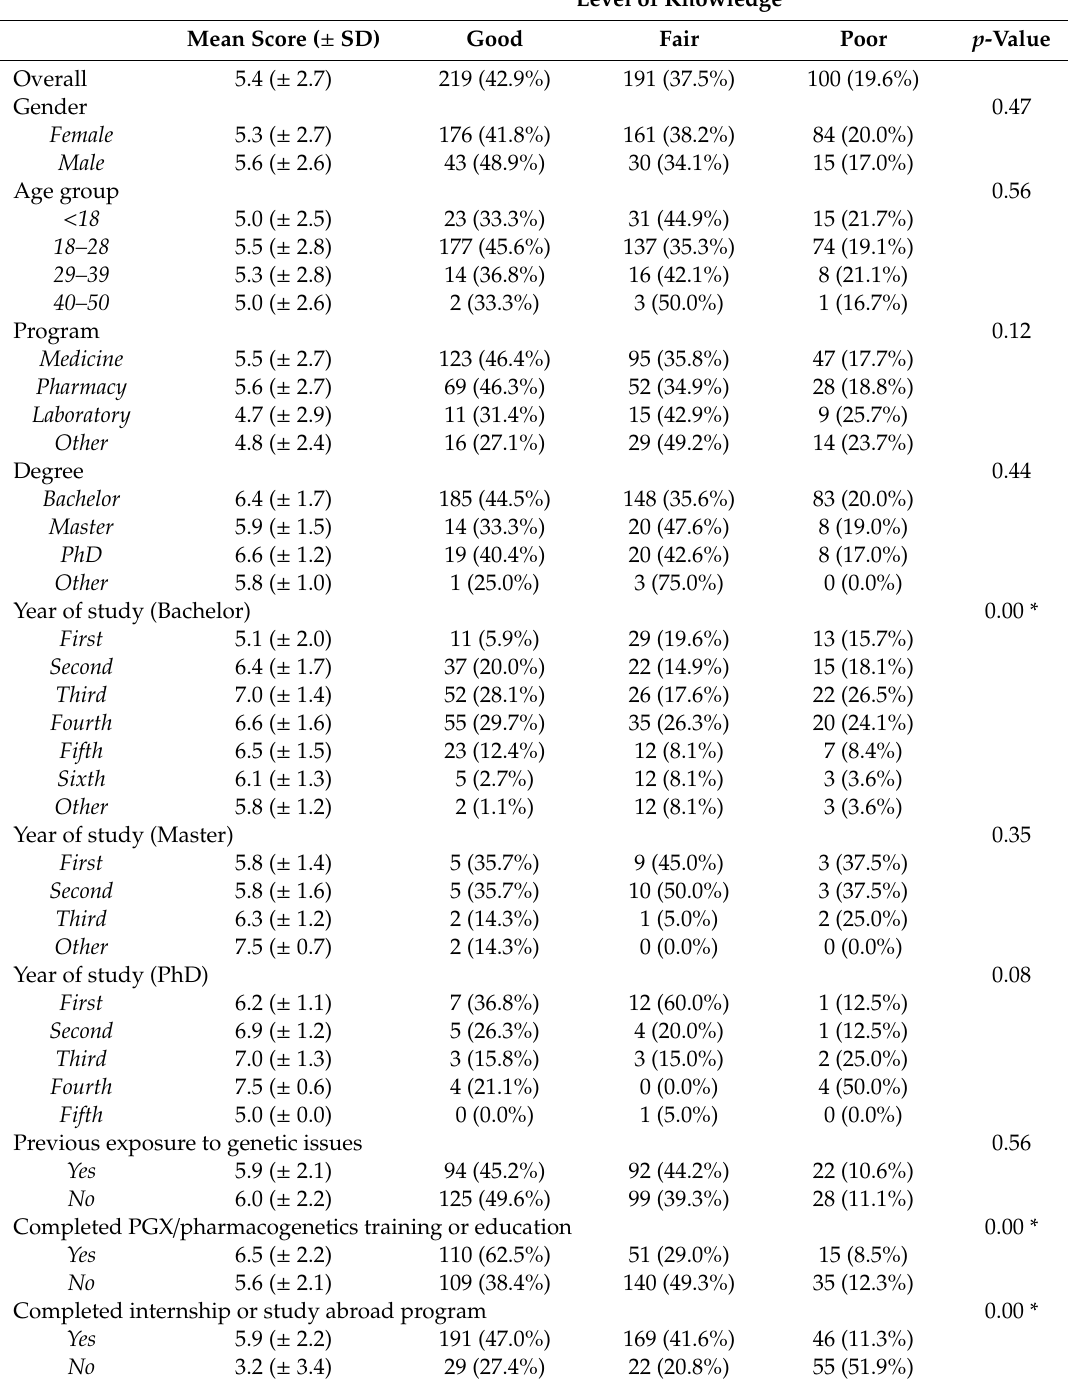
Table 3. Comparison of the level of knowledge by demographic and academic